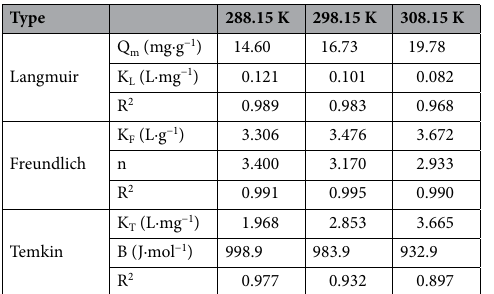
Table 3. Fitting parameters of adsorption thermodynamics for BC-HA adsorption of Ni(II).